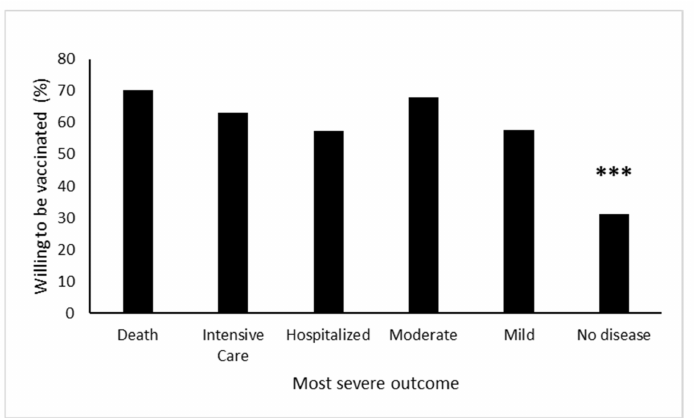
Figure 5. Experience with COVID-19 is associated with intent to vaccinate. Respondents who had personal experience with someone with COVID-19 disease were significantly more likely to report being willing to be vaccinated in the next 30 days (*** χ 2 = 19.26, p < 0.001). No significant differences were found between any groups who had personal experience with disease patients. The respondents were asked to list the most severe outcome if they knew more than one person with COVID-19.